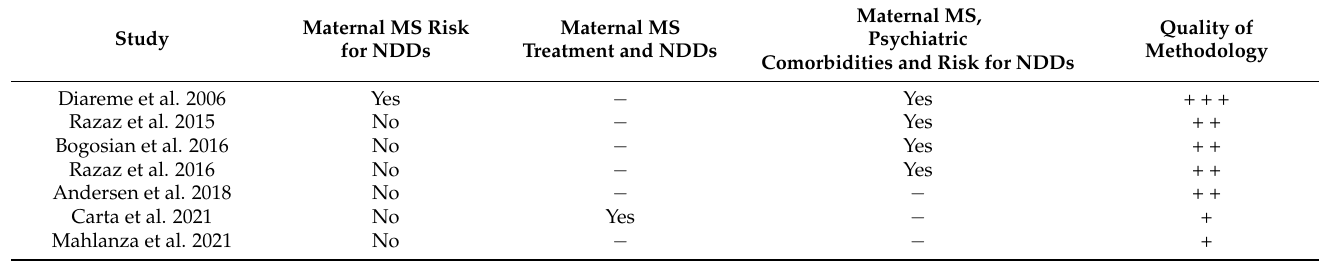
Table 3. Main topics addressed by selected studies investigating the relationship between mater- nal MS and neurodevelopmental outcome in offspring: risk of NDDs, maternal pharmacological treatment for MS and co-occurring maternal psychiatric conditions. Quality of Comorbidities and Risk for NDDs